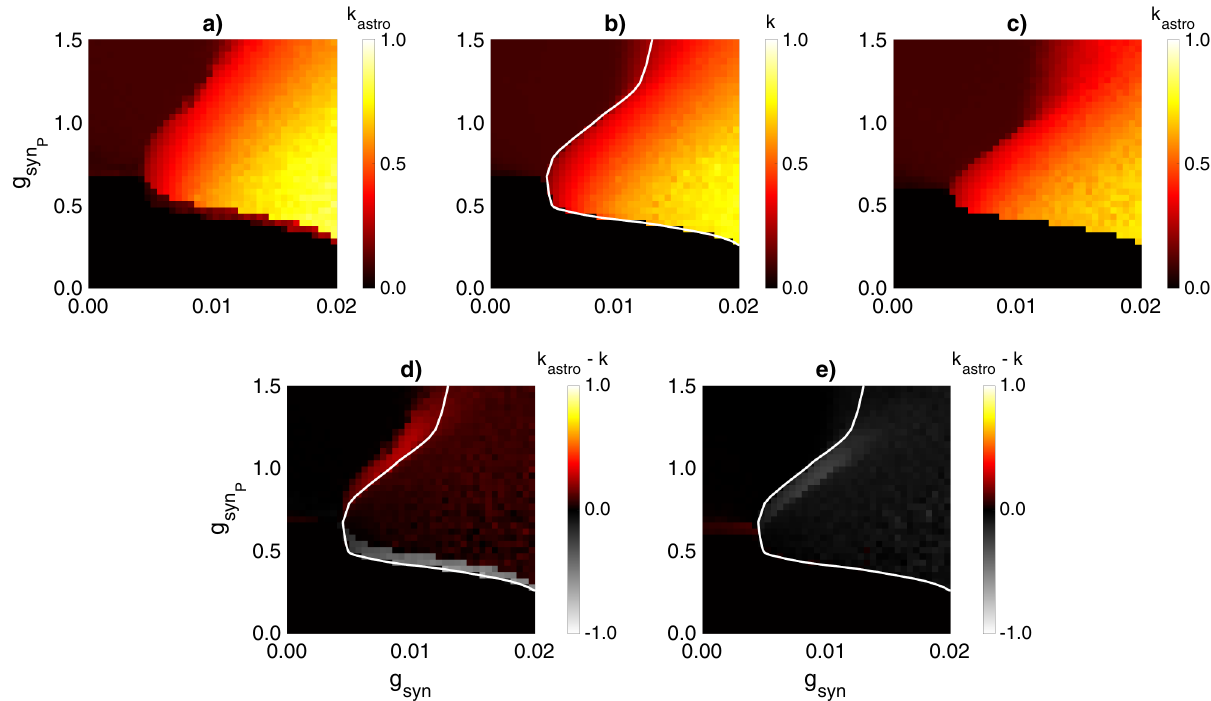
Figure 5. Influence of the astrocyte-induced modulation of the excitatory synaptic transmission on the interneuron network coherence. Mean network coherence, k , without astrocytic regulation ( b ) and during astrocytic regulation of synaptic transmission, k astro , ( a , c ) is plotted against the strength of excitatory synaptic transmission ( g syn ) and the synaptic weight between interneurons ( g syn ). Astrocyte-mediated depression, P g astro = − 0.3 , ( a ) and facilitation, g astro = 0.3 , ( c ) of the excitatory synapses. ( d ) Difference between ( a ) and ( b ). ( e ) Difference between ( c ) and ( b ). The white line corresponds to the border of the coherence region in the interneuron network without astrocytes ( k = 0.4). Each pixel represents an average of over 10